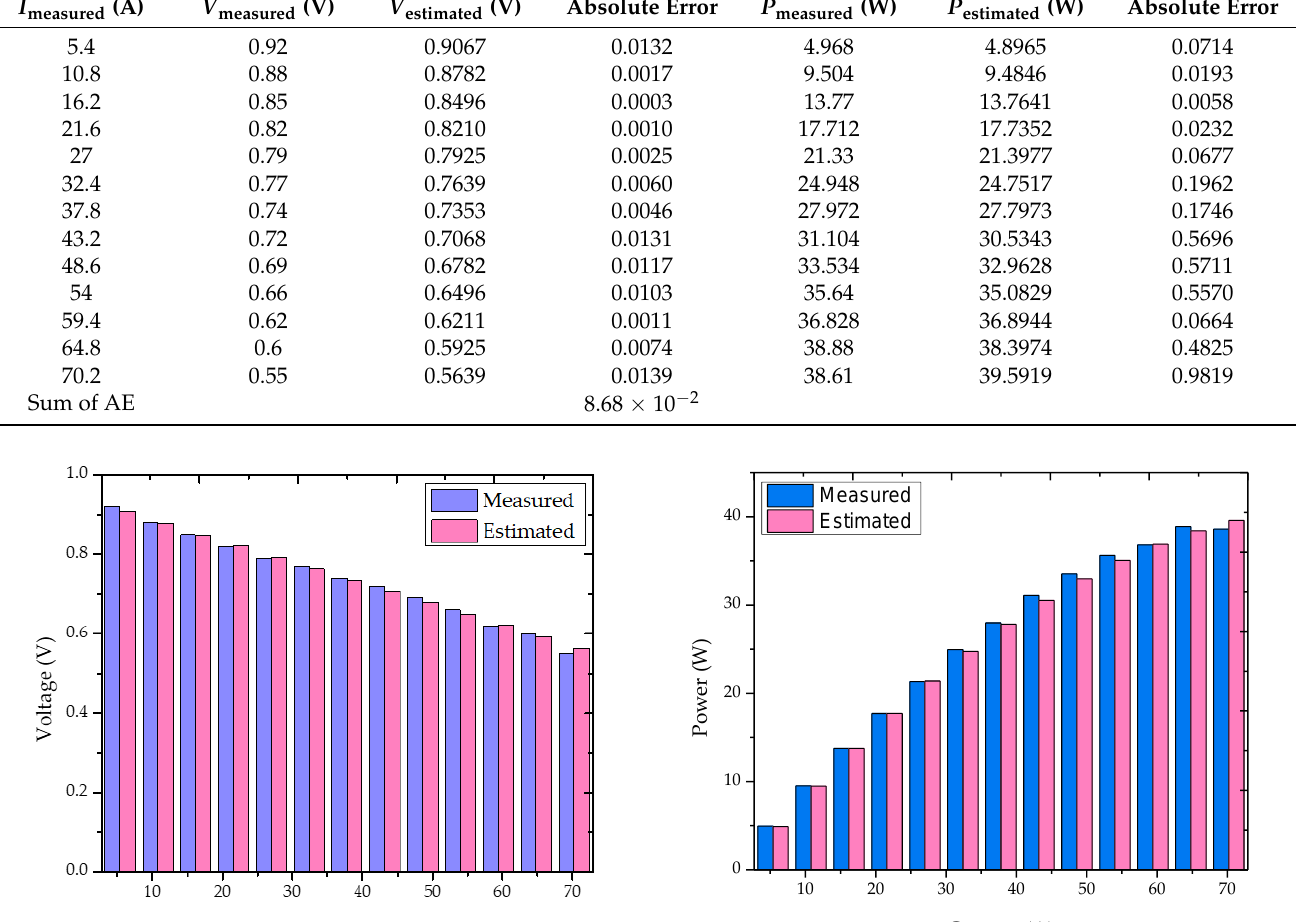
Figure 3. Evaluation between the experimental and the simulated data produced by OBAOA technique for Ballard Mark V PEMFC.